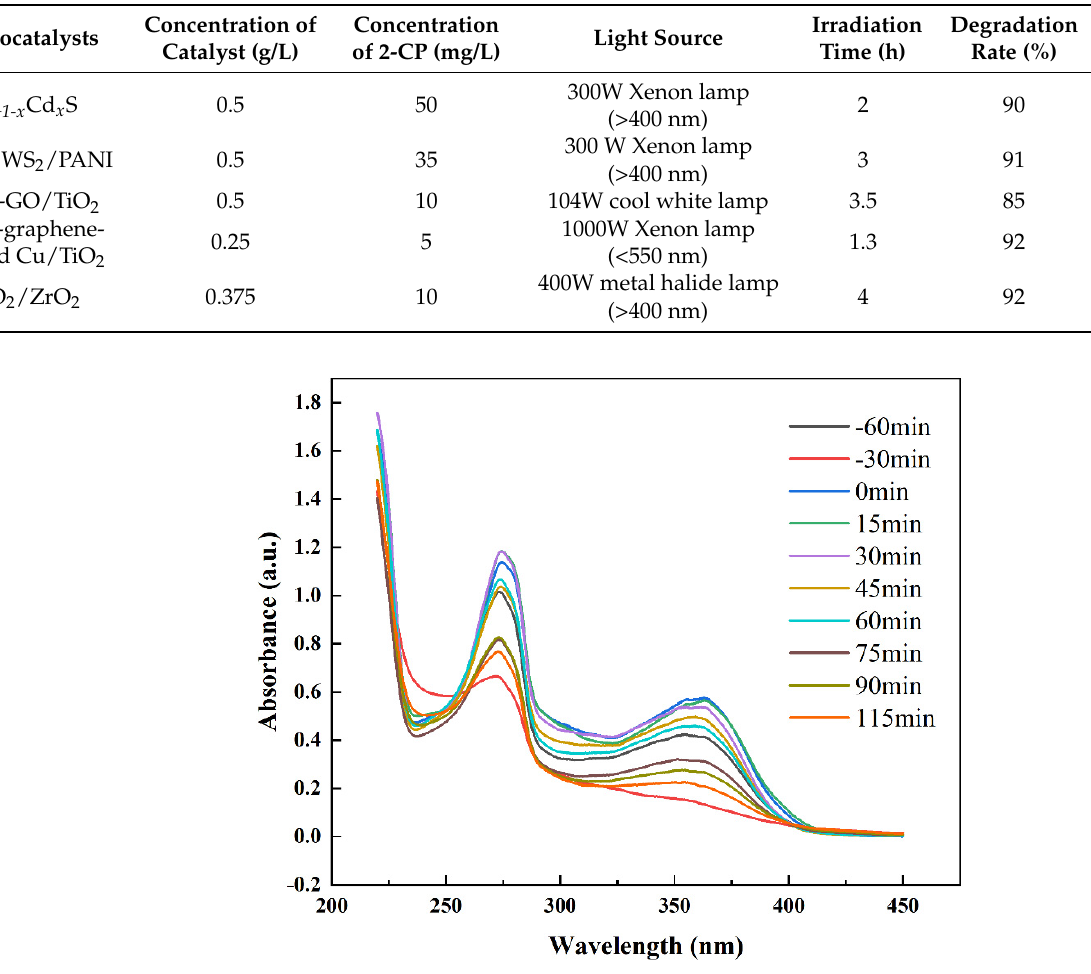
Table 2. Comparison of the performance of different photocatalysts for the degradation in 2-CP.